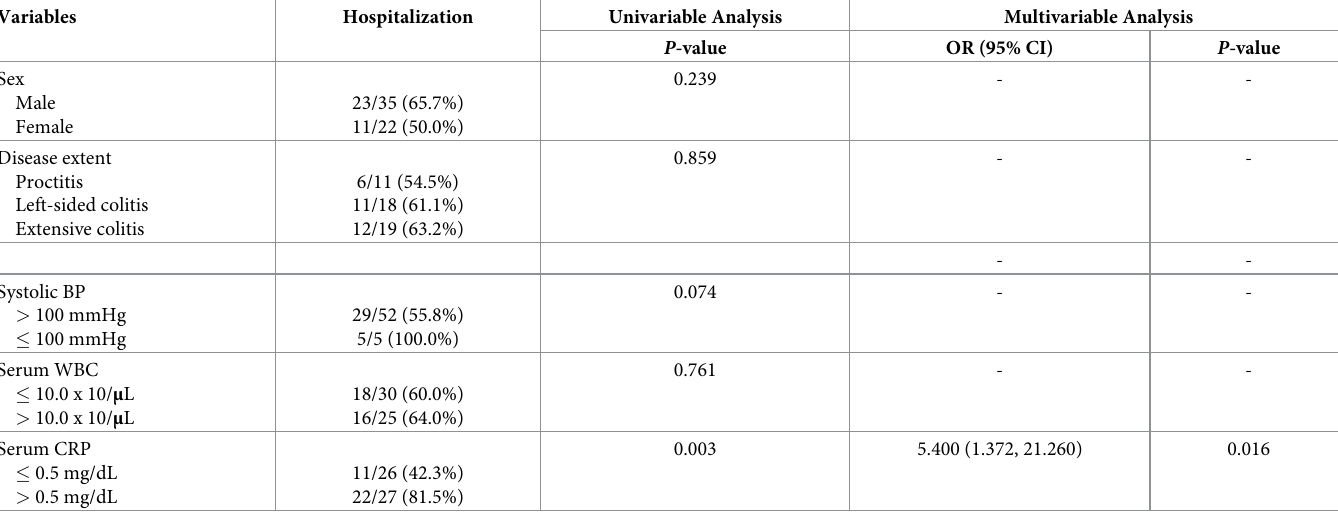
Table 4. Risk factors for hospitalization in ulcerative